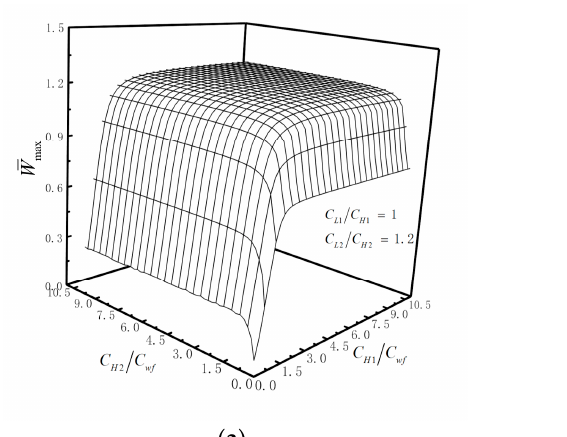
η versus W max max W